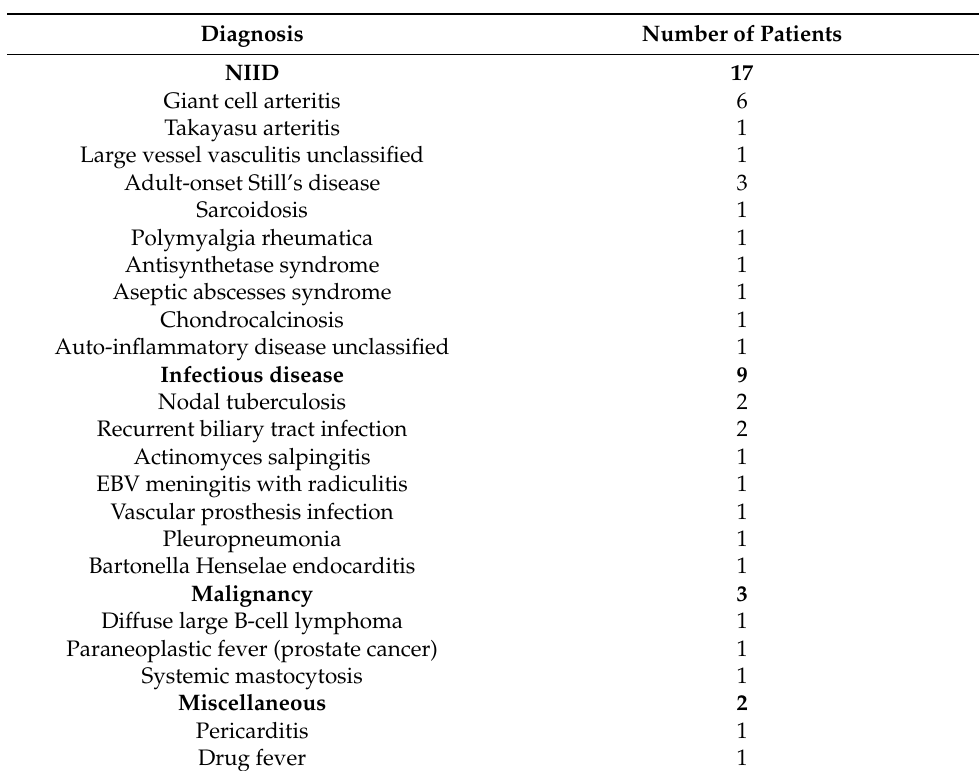
Table 3. Diagnoses obtained in FUO